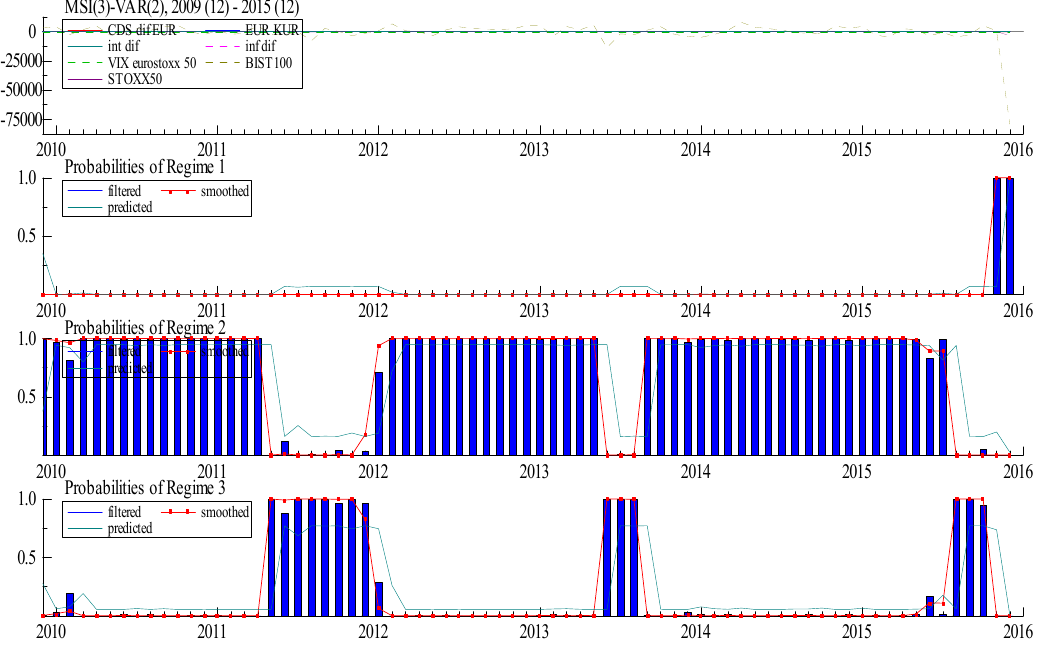
Table 7. Response of EXC to 1% positive shock in other variables in regime 1.